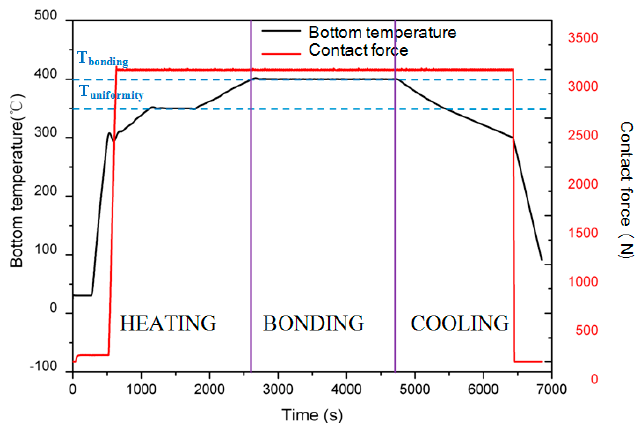
Figure 4 . The optimized temperature curve of Au/Si eutectic wafer bonding. Figure 4. The optimized temperature curve of Au/Si eutectic wafer bonding.